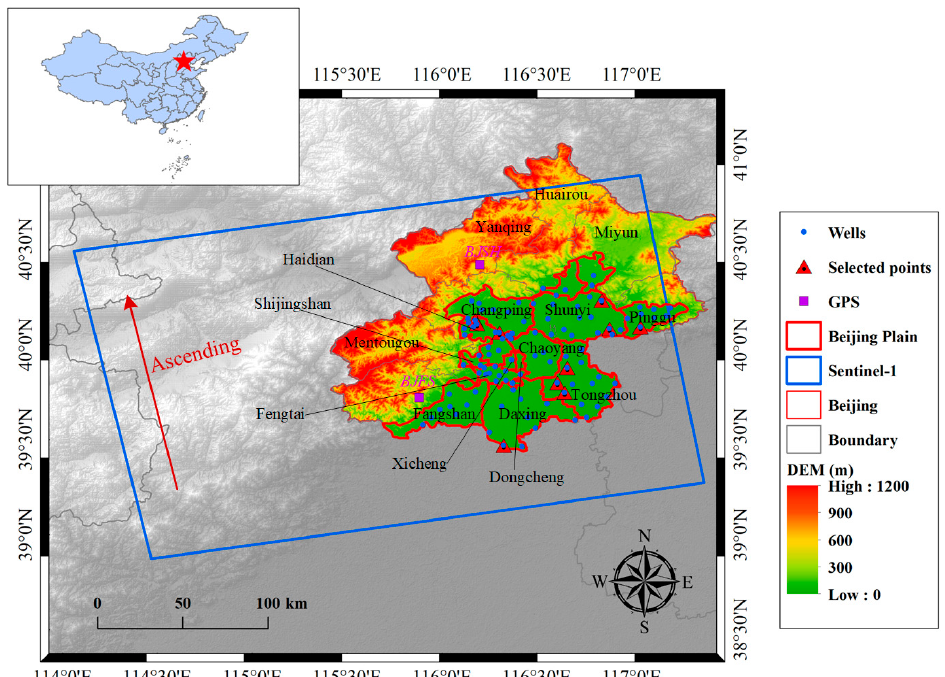
Figure 1. The geographical overview of the study area.